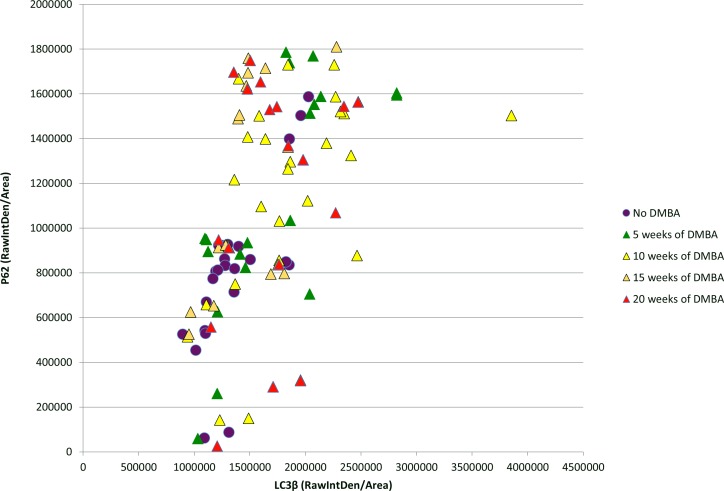
LC3β and p62 immunofluorescence levels for each FVB/N mouse over the DMBA treatment time course as determined by FIJI analysis of 20x images.The above graph shows that in general FVB/N treatment groups are very similar to each other without profound differences in autophagic function. ANOVA analysis demonstrated a statistically significant increase in only in LC3β at 10 weeks of DMBA treatment compared to no DMBA treated mice (p-value = 0.001), indicating increase in autophagic function at this one time point compared to others. There were no significant differences with regards to p62 levels.